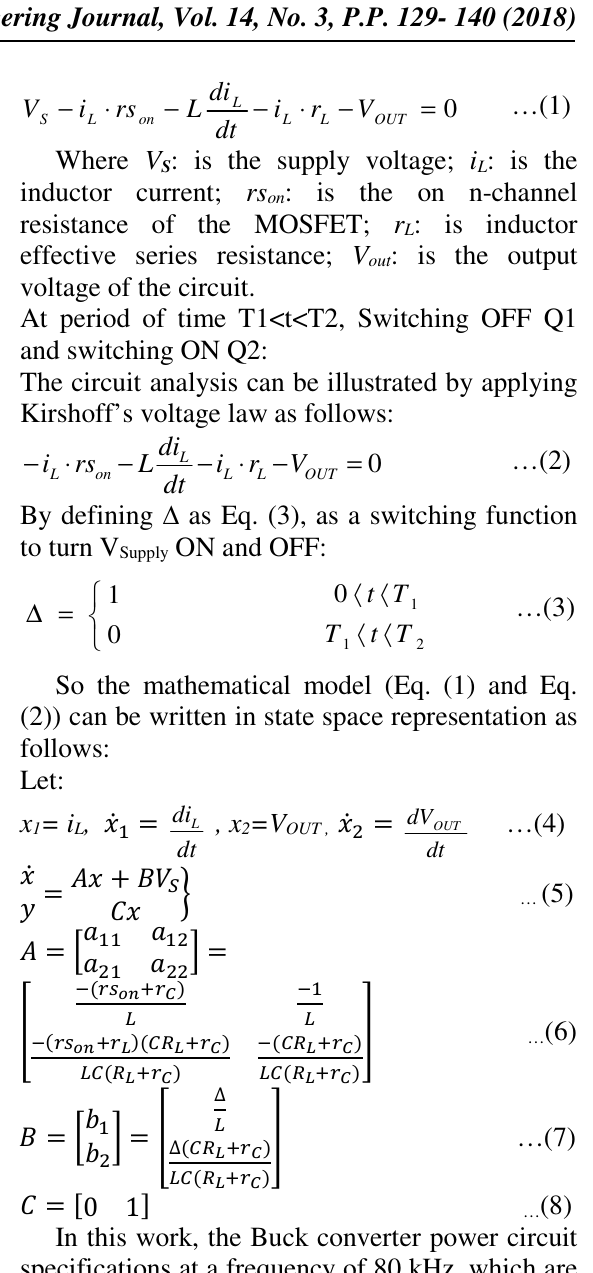
Fig. 1. Schematic diagram of Synchronous Buck power stage [8].